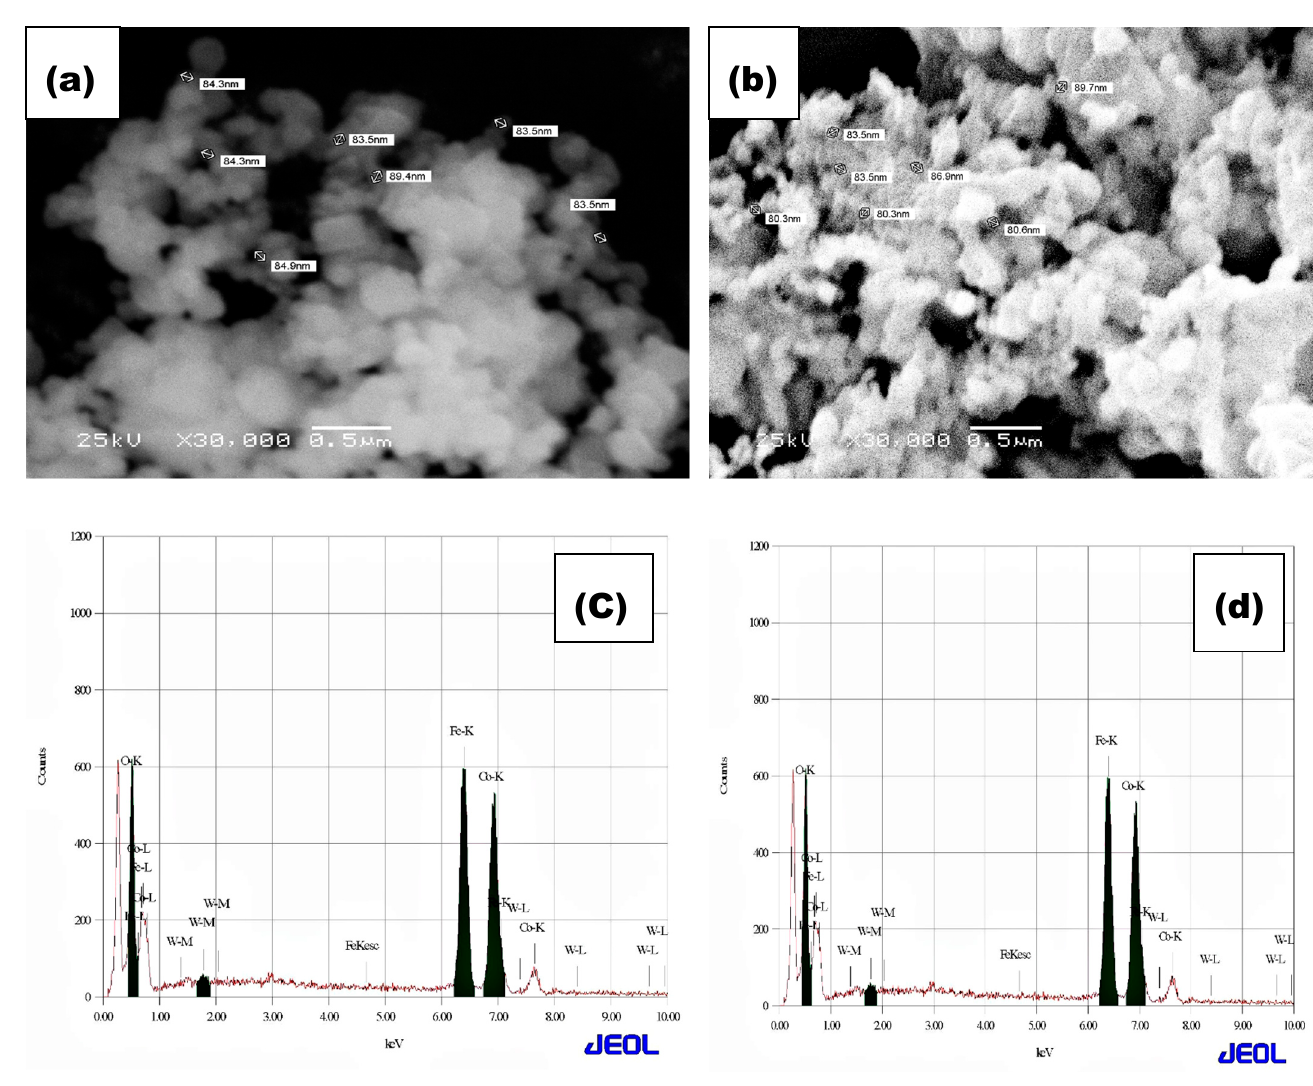
Figure 4. SEM of ( a ) CoFe 2 O 4 and ( b ) CoFe 2 O 4 (0.5% W-doping), and EDX of ( c ) CoFe 2 O 4 and ( d ) CoFe 2 O 4 (0.5% W-doping).